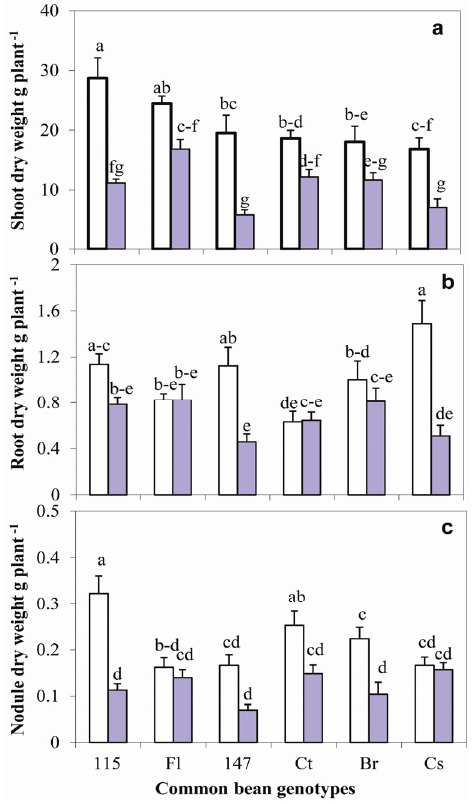
Figure 1. Shoot ( a ); root ( b ) and nodule ( c ) biomass of six common bean genotypes grown under sufficient phosphorus (P) ( empty bar ) versus low P ( filled bar ) soil. Data are means ± se of eighteen replicates harvested at flowering